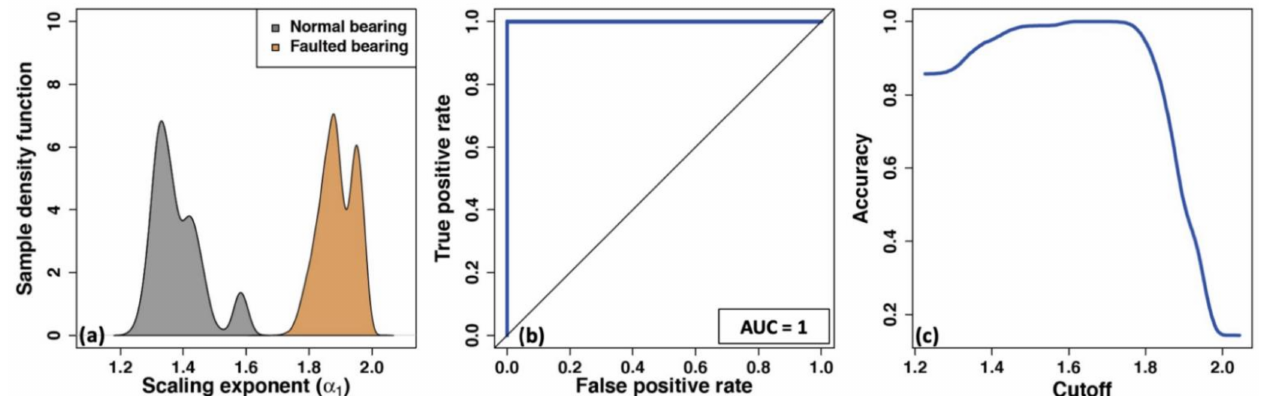
Figure 7. ( a ) Scaling exponent ( α 1 ) distributions of bearing vibration signals (1000 samples each) collected from healthy and faulted bearings. ( b ) Receiver operating characteristic (ROC) curve for the proposed method. ( c ) Accuracy vs. cutoff